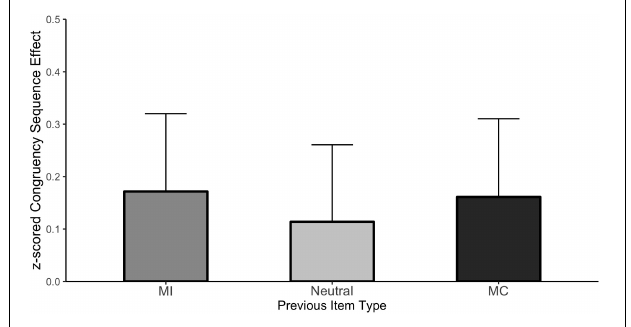
FIGURE 5 | CSE in Experiment 2. Error bars represent the 95% HDI.